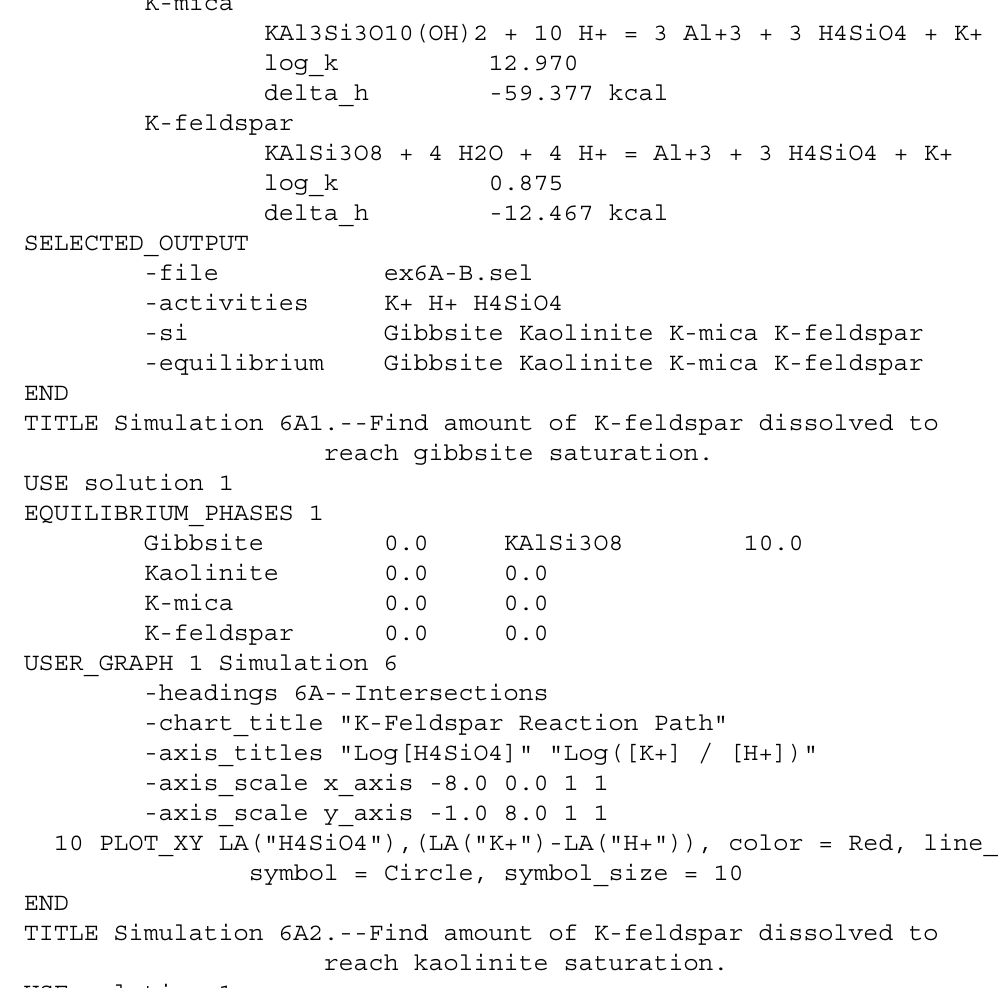
Table 21. Input file for example